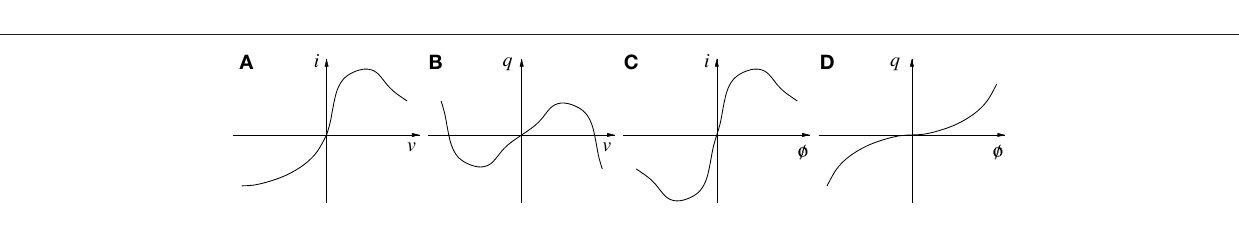
device’s charge and voltage. (C) An inductor is defined by a static relationship between a device’s current and flux. (D) And a memristor is defined by a static relationship between a device’s charge and flux.